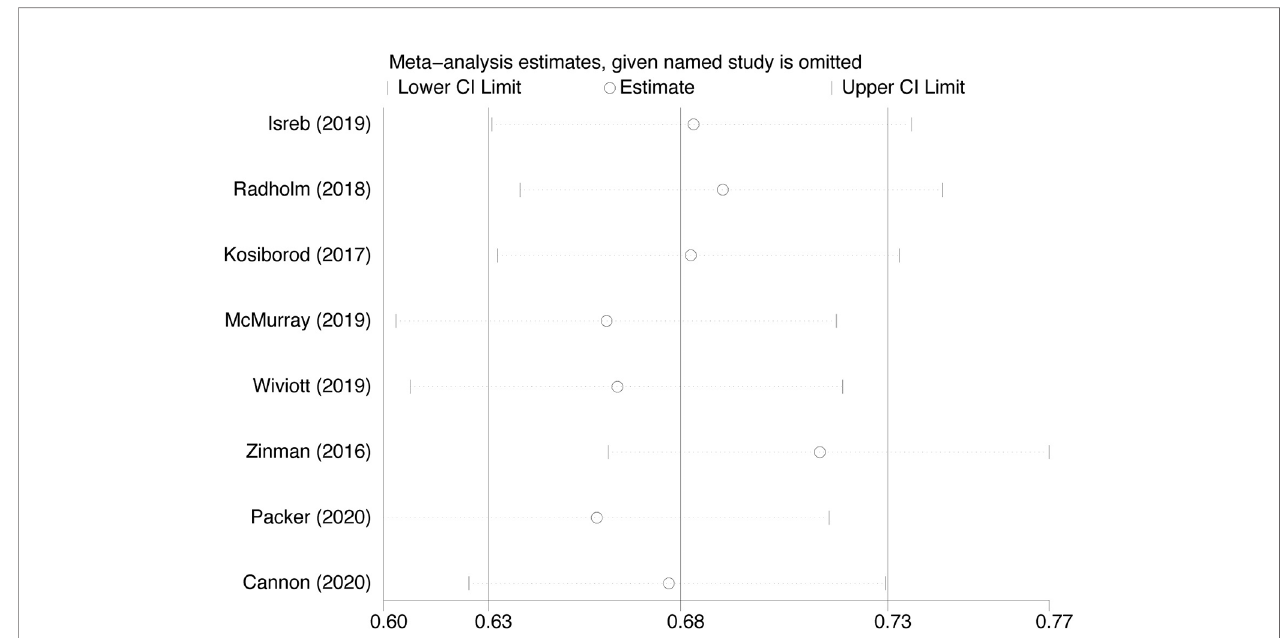
FIGURE 7 | Sensitivity analysis for Heart failure hospitalization in type 2 diabetes patients receiving SGLT2 inhibitors versus